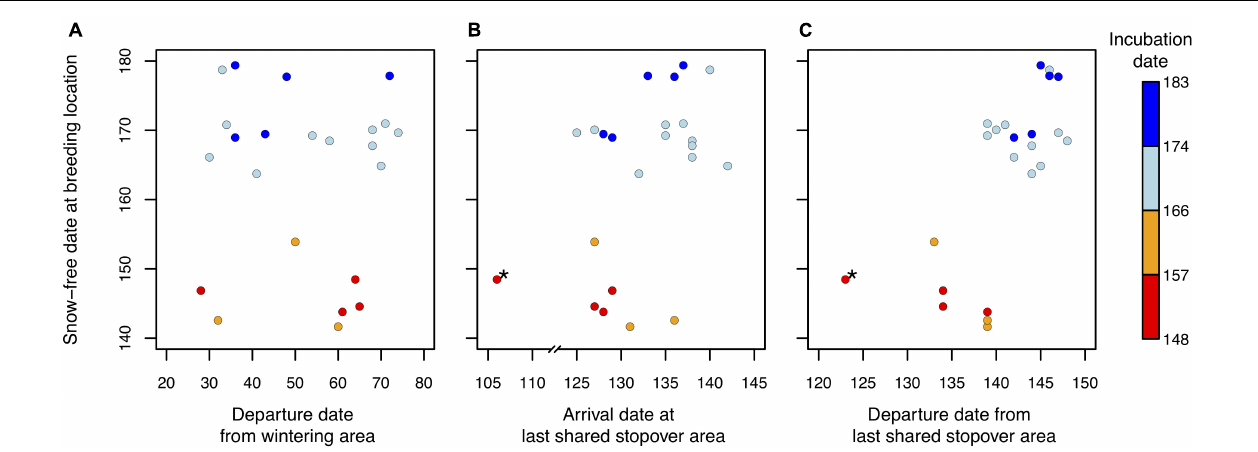
FIGURE 3 | Relationships between timing of breeding site availability (mean snow-free date) and (A) departure date from the non-breeding (wintering) area, (B) arrival or (C) departure date from the last shared stopover site in the nearctic temperate grasslands of the Midwestern United States in tundra nesting American Golden-plover ( Pluvialis dominica ). To help visualize geographical relationships, axis were transposed. Colors indicate the onset of incubation for each individual ( n = 23). A slight neutral offset was added to overlapping points to facilitate interpretation. Day 1 = January 1st. “*” signifies an outlier (Grubb’s test, p < 0.05, see section “Materials and